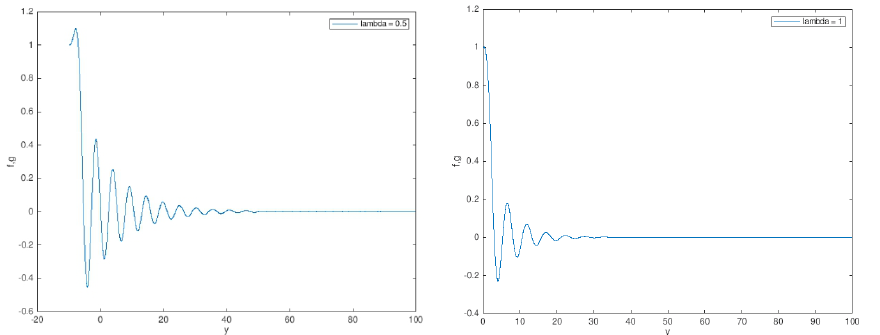
Figure 1. TW solutions for λ = 0.5 ( left ) and λ = 1 ( right ). Note that both solutions f , g are superposed and represented by the blue line. Note that the advection term (cid:101) << λ 0 ∼ λ .